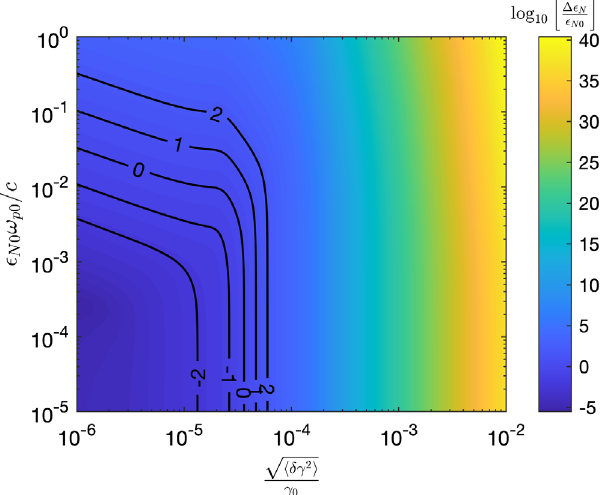
FIG. 8. Relative emittance growth Δ ϵ erating stages as a function of constant relative energy spread ffiffiffiffiffiffiffiffiffiffi p = γ 0 and initial normalized emittance ϵ h δγ 2 i contours show the base-10 logarithm of Δ ϵ